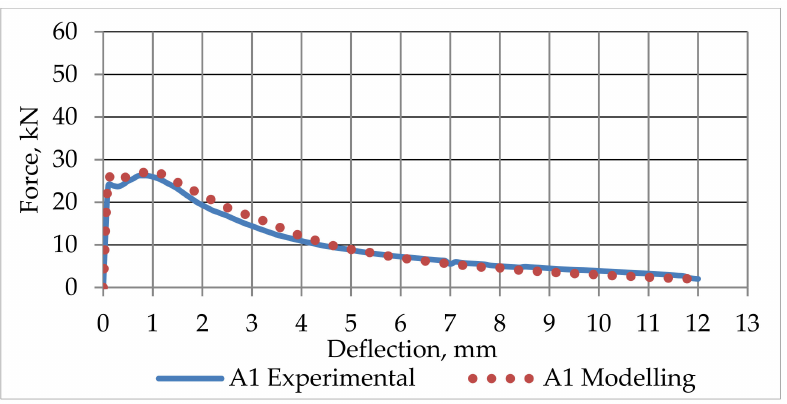
Figure 27. Experimental and modelling graphs for Group A1.